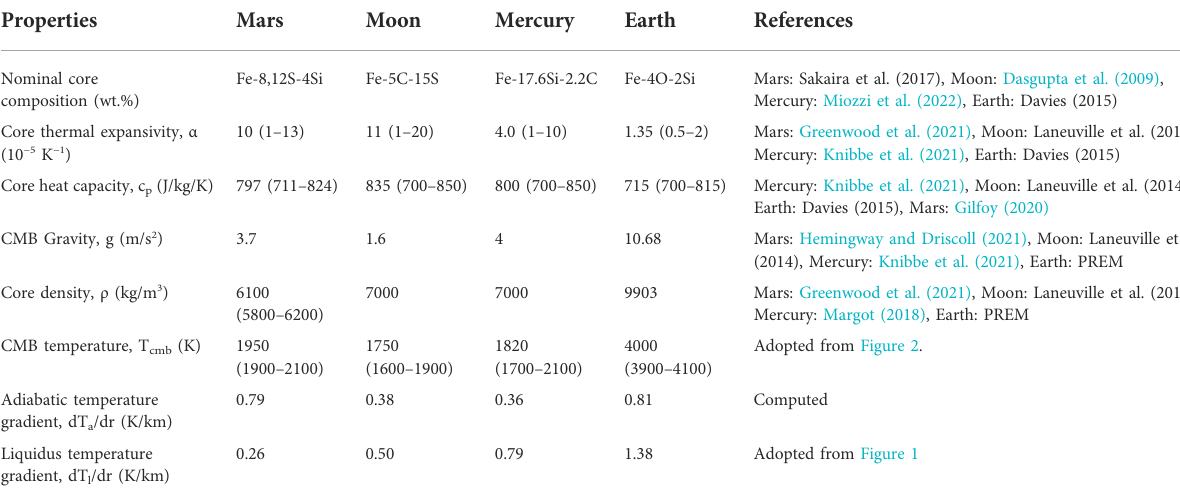
TABLE 2 Material properties of Mars, Moon, Mercury, and Earth used in Figures 11, 12. CMB is core-mantle boundary. PREM is the Preliminary Reference Earth Model of Dziewonski and Anderson (1981) . Properties Mars